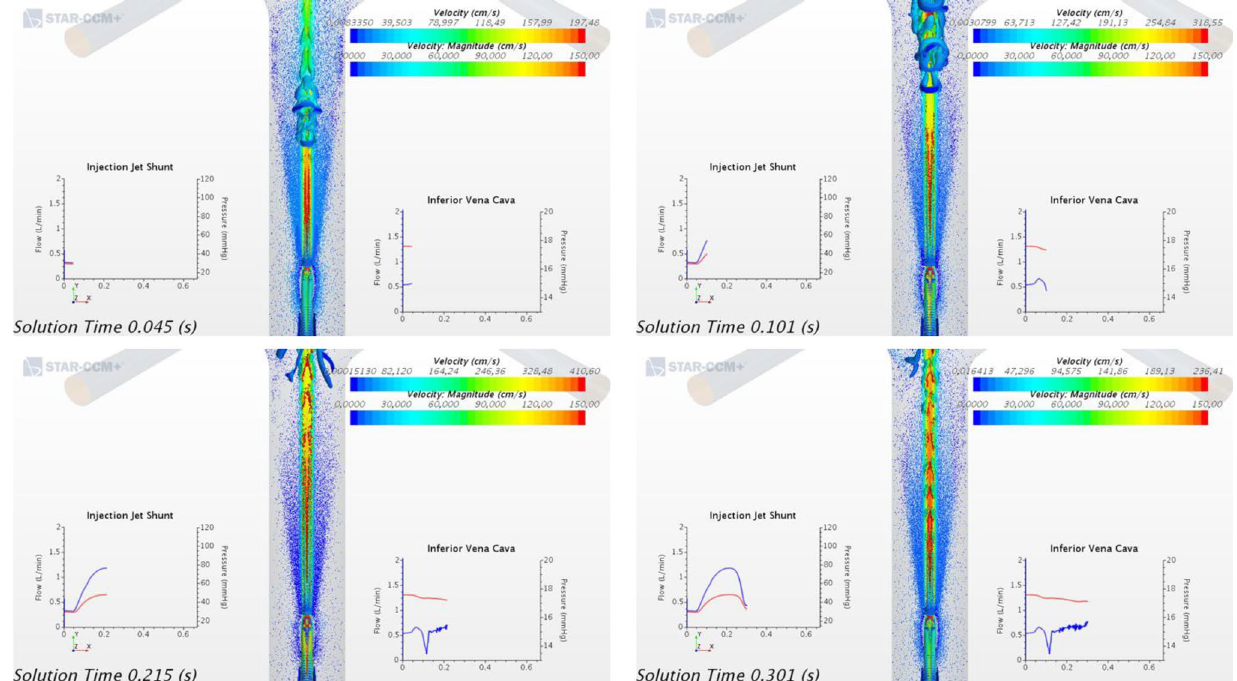
Figure 5. Contour velocity plot of vortex iso-structures for a 2 mm circular IJS nozzle, 7 cm IJS-TCPC distance and 7 mm fenestration across a single heart cycle. The x–y plots display pressure (blue) and volume flow rate (red) sampled in the IJS shunt and the IVC. Displayed are the flow velocity (“Velocity”) and coherent structure velocity (“Velocity: